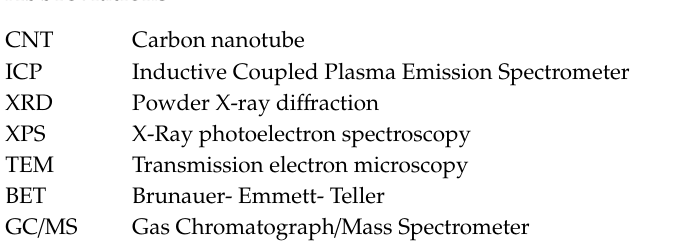
Figure 7. ( a ) Possible catalytic pathway in the transfer hydrogenation of phenol. ( b ) Result of recycling tests for Ni/CNT catalyst in the transfer hydrogenation of phenol.